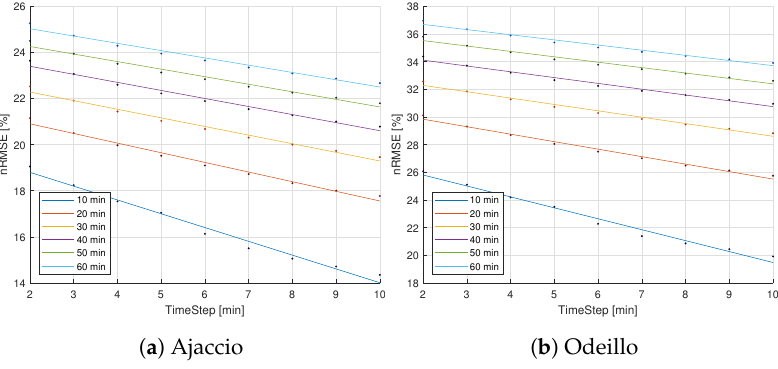
Figure 11. Error (nRMSE) vs. time-step ( ∆ t ) for time-steps 2 to 10 min and horizons 10 to 60 min. Table 3. Fitting results for Ajaccio and Odeillo, horizons 10 to 60